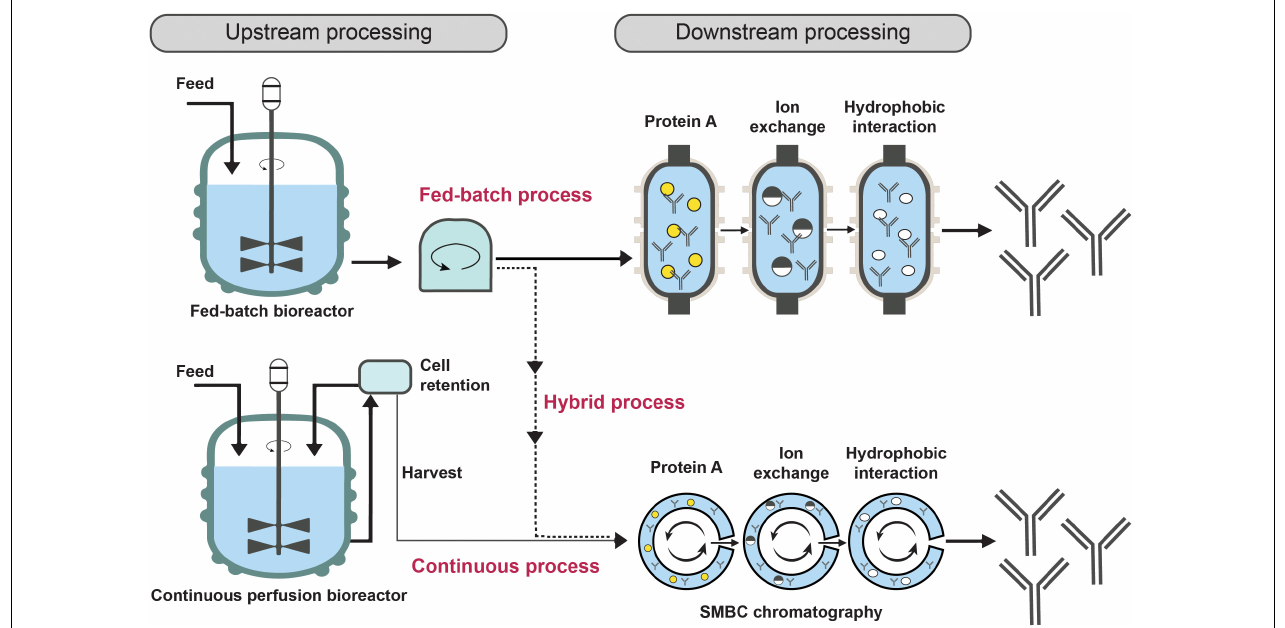
FIGURE 1 | Three different antibody manufacturing process strategies. The fed-batch process involves the one-off supply of nutrients for the CHO cells for a complete cultivation process. Subsequently, the antibodies are harvested and purified via single-batch chromatography. This is not the case for the continuous perfusion process, where cells are retained while the growth medium containing the antibodies is continuously replaced with fresh medium in a perfusion bioreactor. Subsequently, the media undergoes simulated moving bed chromatography (SMBC), where the chromatographic processes are performed via a continuous process as well. The hybrid process is a combinantion of the two previous approaches in that it involves the use of a fed-batch bioreactor followed by SMBC instead of single-batch chromatography.